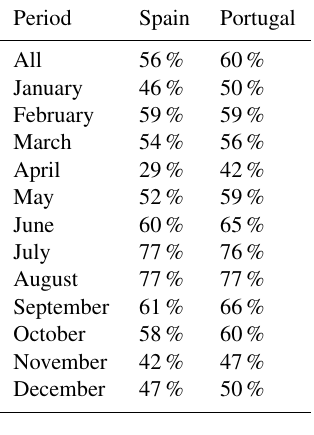
Table 1. Mean data availability of TROPOMI TrC-NO 2 over Spain and Portugal, on average over 2018–2021.